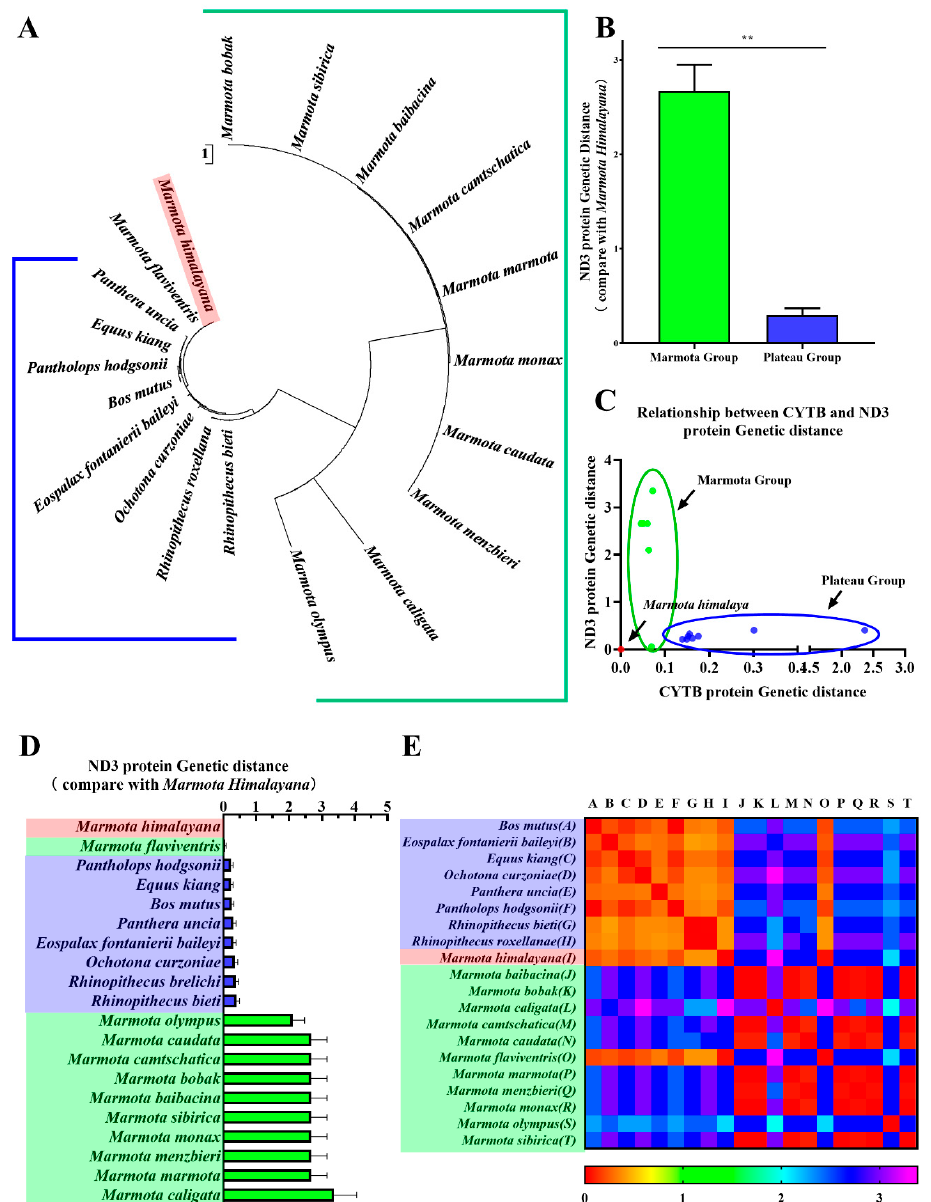
Figure 4. Phylogenetic analyses of ND3 protein. Phylogenetic trees of ND3 protein were constructed in MEGA with the scale bar set to 1 to measure genetic distances ( A ). One-way ANOVA revealed a significant difference between the groups (** p < 0.01) ( B ). A scatter plot shows the correlation between genetic distances calculated for CYTB and ND3 amino acid sequences by species ( C ). Genetic distances of the marmot group and plateau group were plotted as a bar chart ( D ). A heatmap represents the correlation coefficients of ND3 protein genetic distance for all species ( E ).